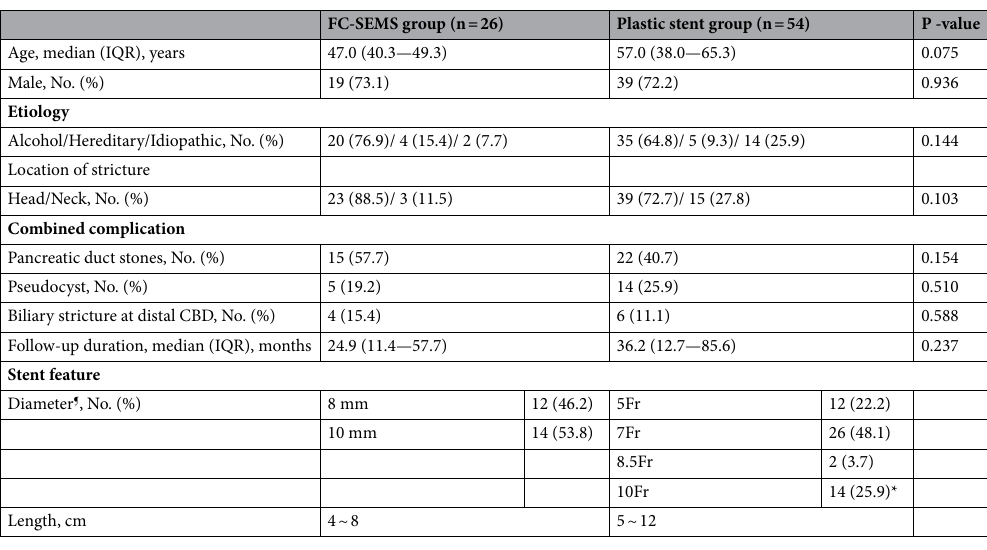
Table 1. Comparison of patients’ characteristics and stent feature. ¶ For the plastic stent group, the maximum stent diameters were described. *Including 4 patients with multiple plastic stent placement (n = 3, 7Fr + 7Fr; n = 1, 10Fr + 7Fr). Abbreviations: FC-SEMS, fully covered self-expandable metal stent; PS, plastic stent; IQR, interquartile range; CBD, common bile